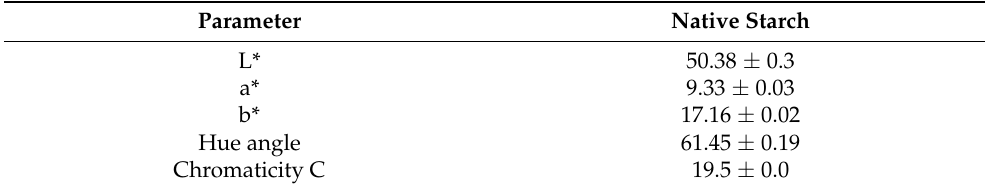
Table 3. Color characteristics of Talisia floresii Standl native